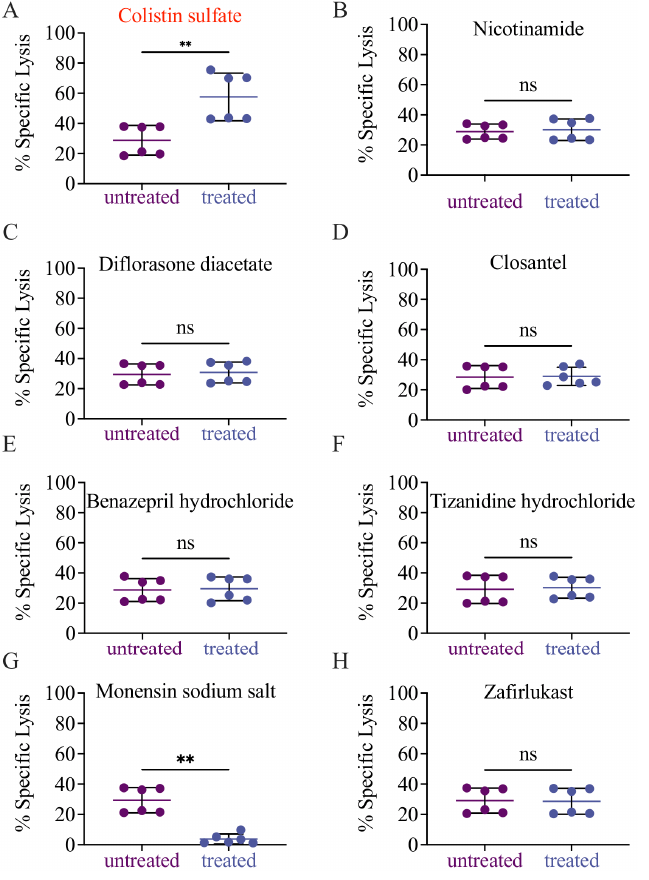
Figure 3. Colistin sulfate salt increases NK92 cytotoxicity against K562-NL. NK92 and K562-NL cells were seeded at an E:T ratio of 1 into 96-well V bottom plates containing either identified drug hits (10 μ M) or DMSO for 5-h at 37 °C. Each drug tested had an independent untreated control. After incubation, the supernatant was subjected to a luciferase release assay. ( A ) Colistin sulfate salt. ( B ) Nicotinamide. ( C ) Diflorasone diacetate. ( D ) Closantel. ( E ) Benazepril hydrochloride. ( F ) Tizanidine